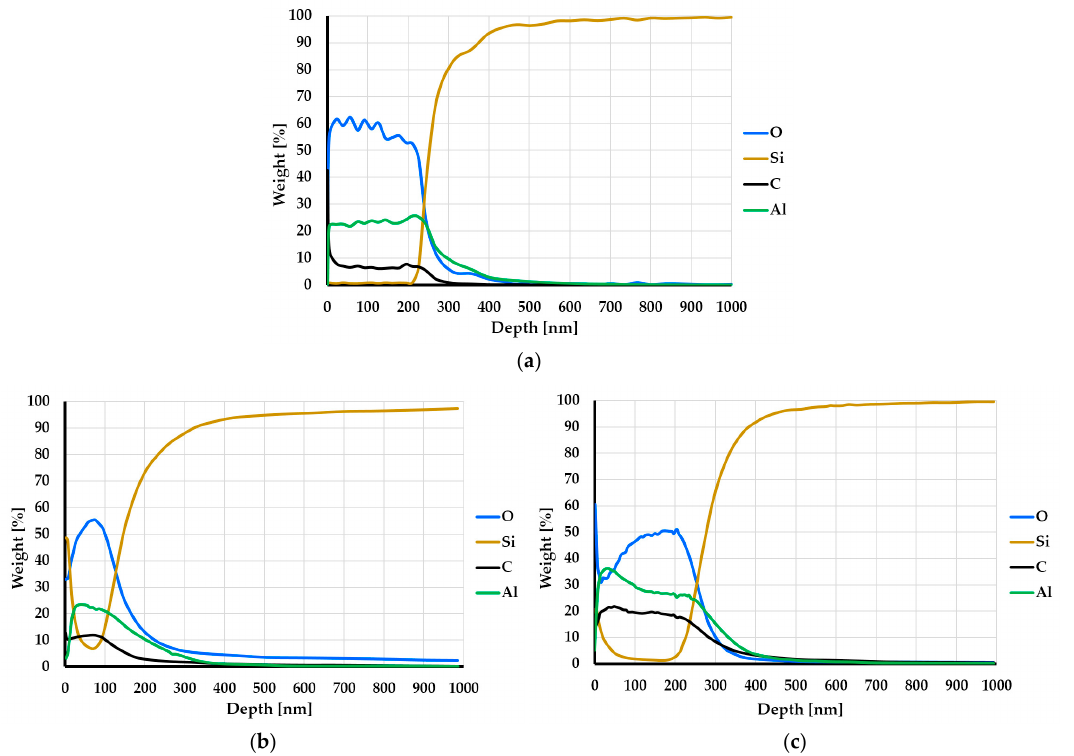
Figure 3. Elemental analysis of Al 2 O 3 ( a ), Al 2 O 3 + G1 ( b ), and Al 2 O 3 + G2 ( c ) coatings with 2% of graphene in sol suspension, heat treated at a temperature of 300 °C.